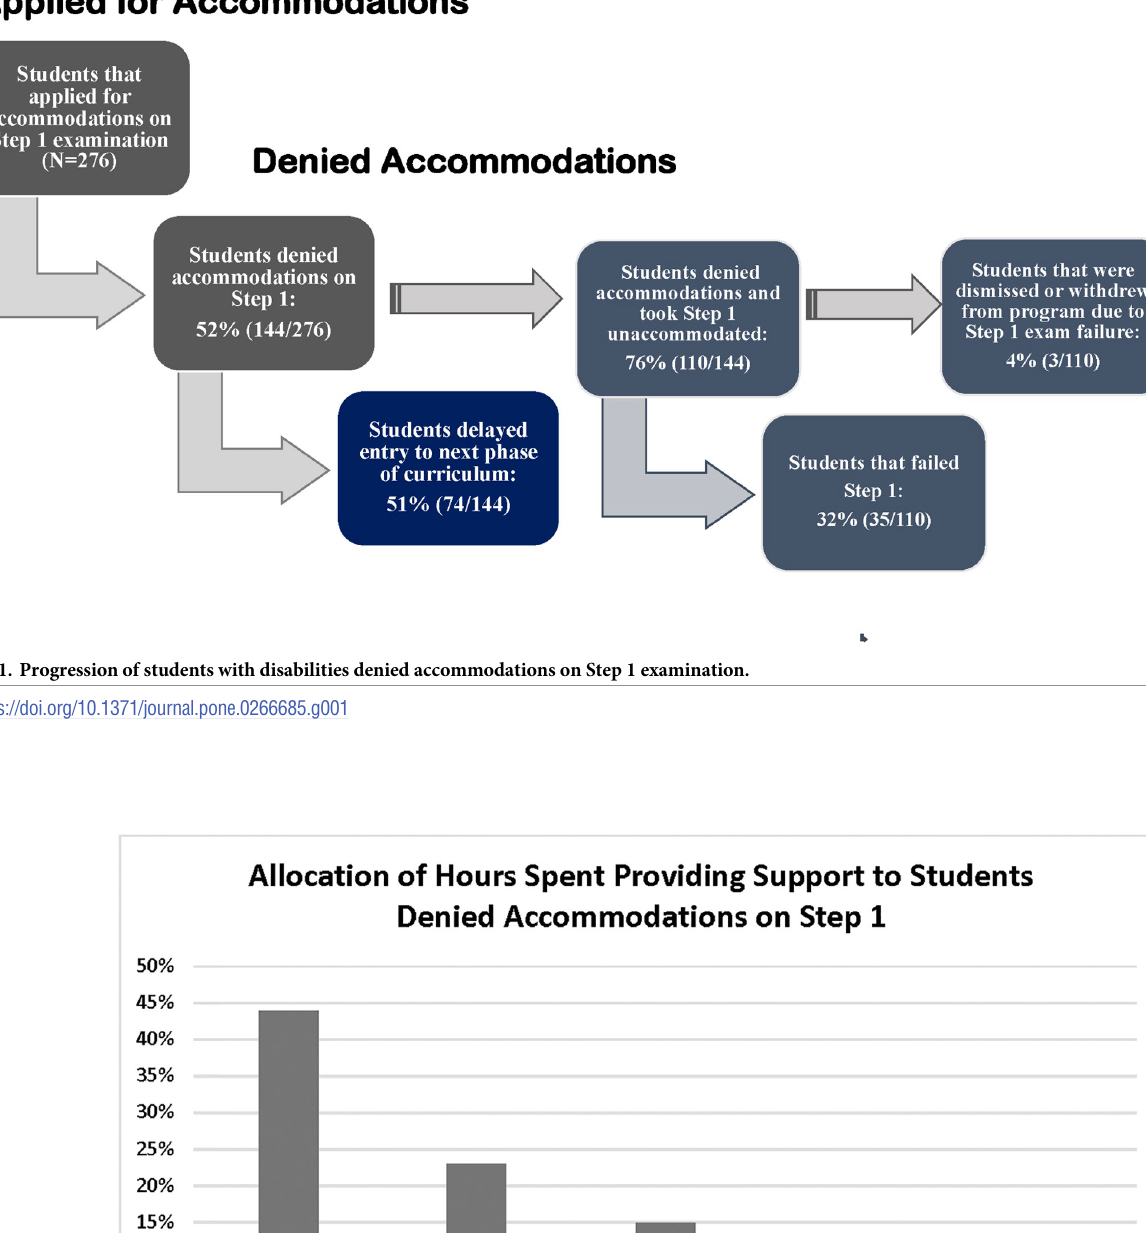
PLOS ONE | https://doi.org/10.1371/journal.pone.0266685 April 14,